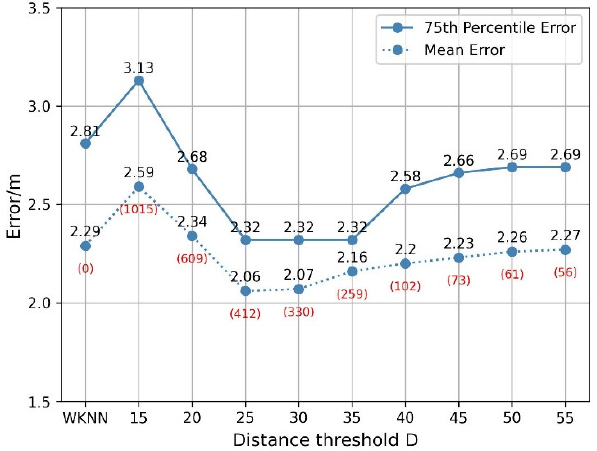
Figure 14. Positioning error for different thresholds.